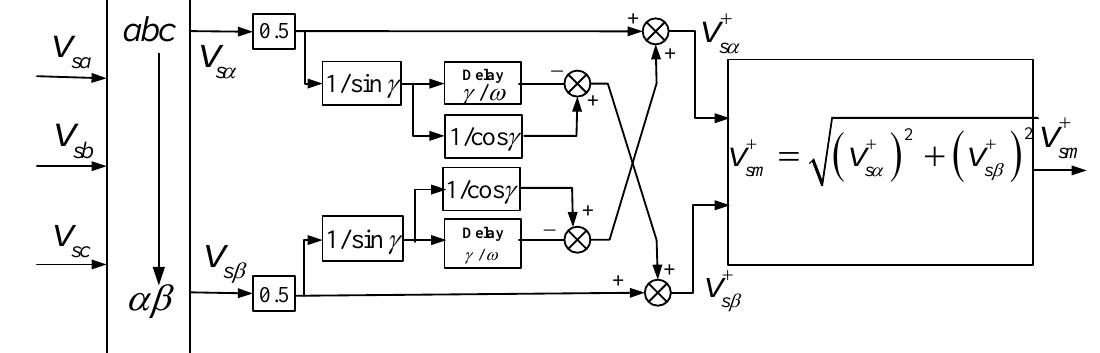
Figure 4. Block diagram of the fast identification algorithm.